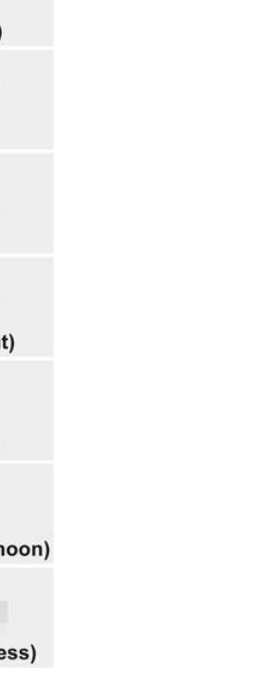
Figure 6. Prey detectability model for a great cormorant demon- strating the effect of illumination. The model is based upon a great cormorant foraging on a capelin ( Mallotus villosus , 10 cm TL) of 60% contrast viewed at a distance of 1.05 m over a range of ambient illumination levels equivalent to those received at the earth’s surface from natural sources between daylight to a moonless night. These span the range of target light levels used in this series of experiments and span the range of ambient light levels that are known to be encountered by cormorants during natural dives [18] (ca 0.5 to 100 lux). Each frame depicts a scene with an angular width of 10 u .